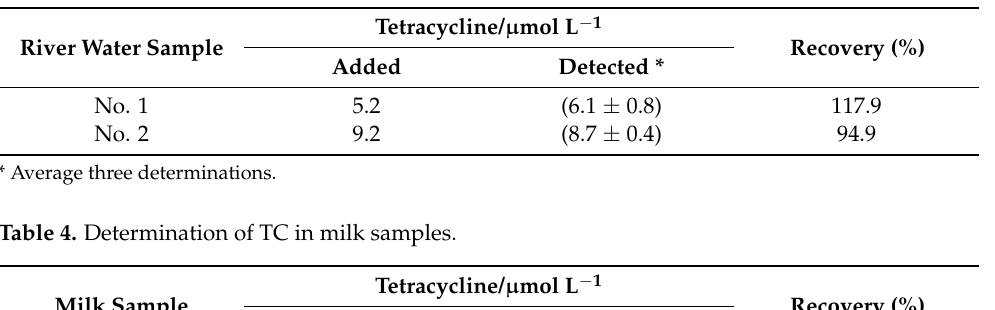
Table 3. Determination of TC in water samples.